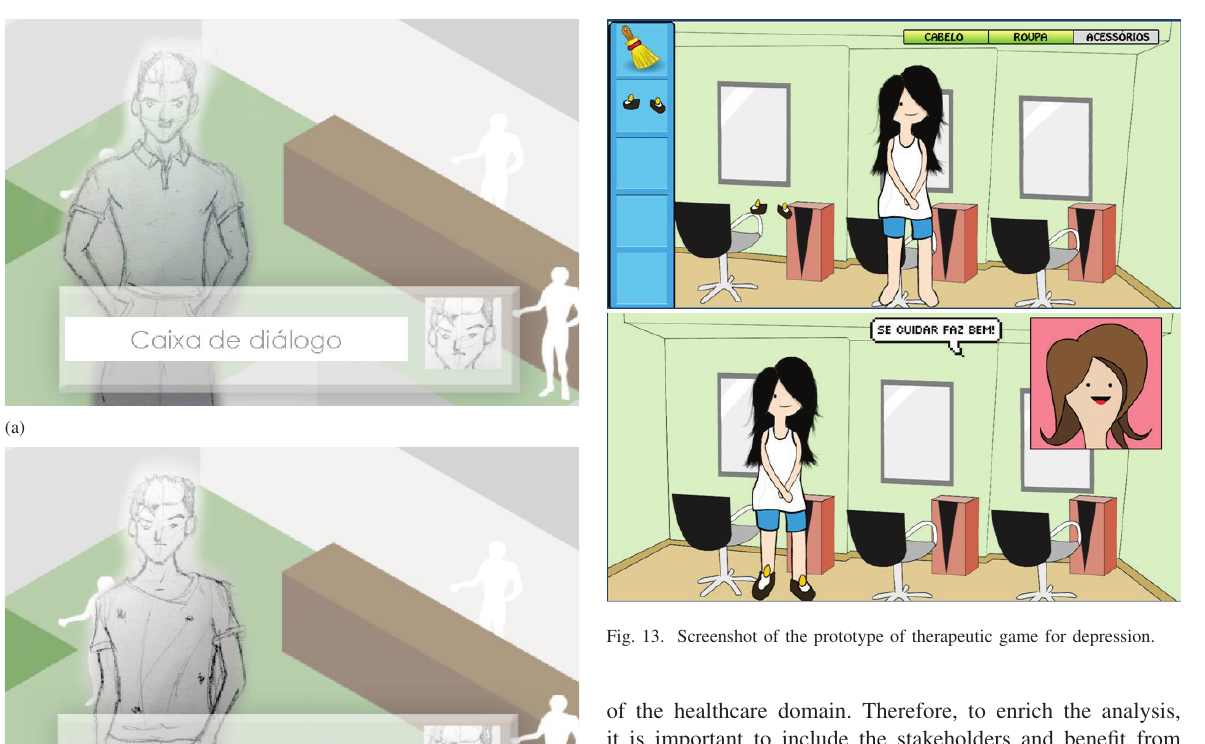
applications benefit from detailed and complete requirements analysis — the more information the designers have, the better the resulting application may become.